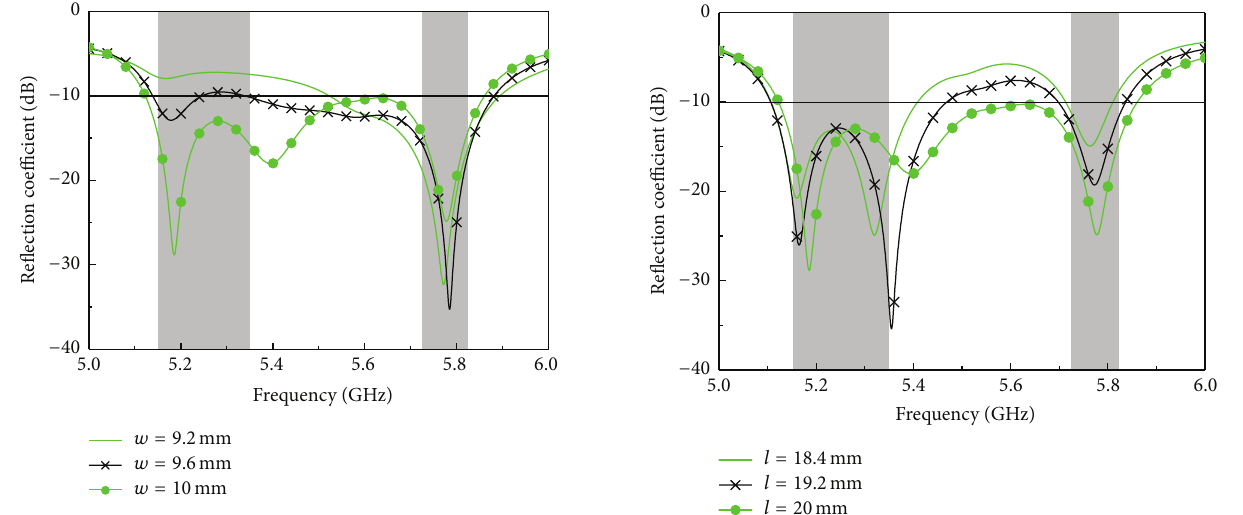
Figure 6: Simulated reflection coefficients for various values of width 𝑤 .